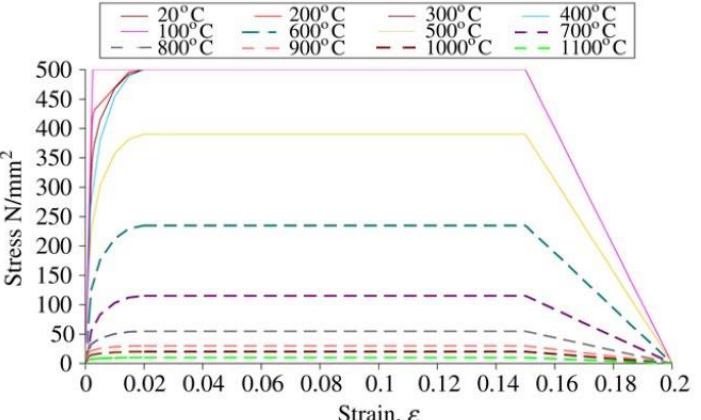
Figure 5. The modelled mesh and element lattices: ( a ) main model, ( b ) channel section and ( c ) IPE beam.